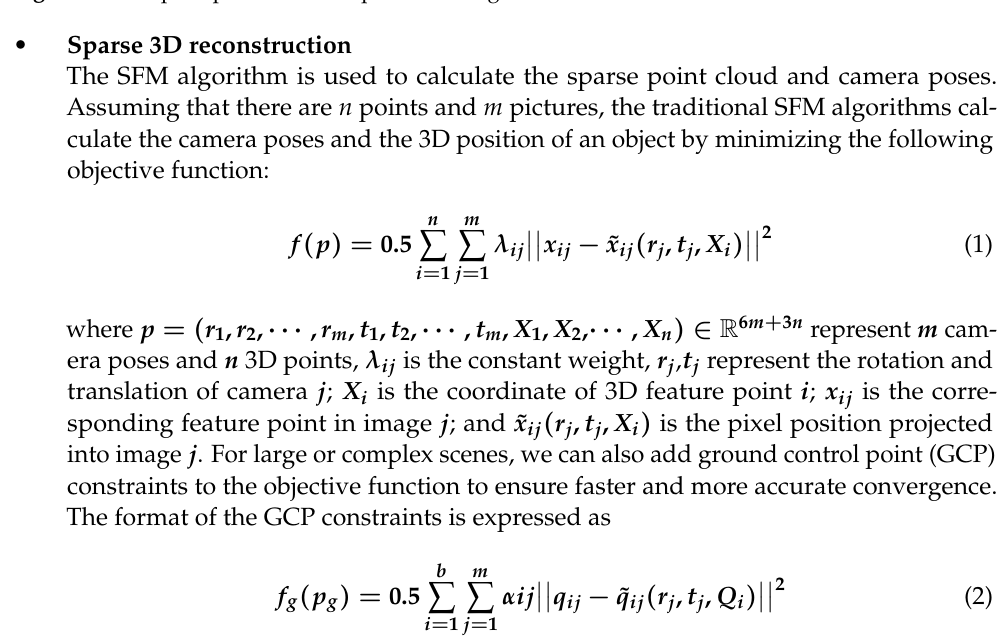
Figure 6. The spark patterns could provide a large number of